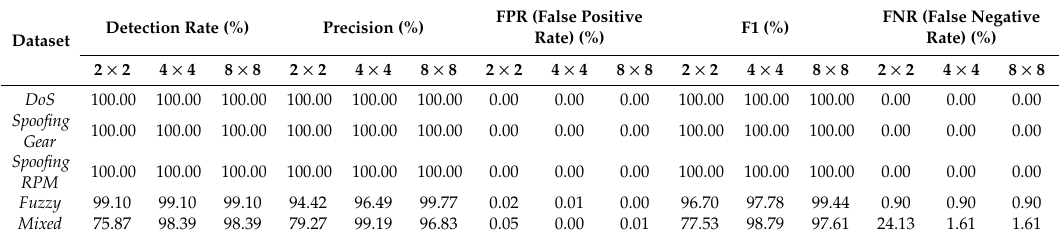
Table 7. Evaluation metrics for the XYF – K algorithm.